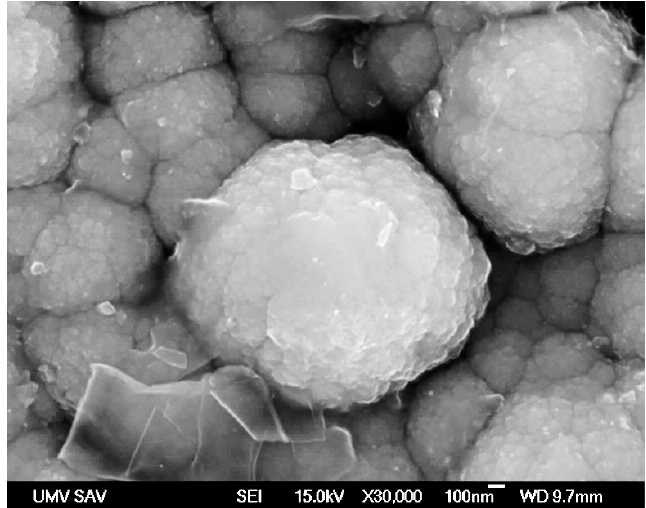
Figure 1. SEM image of the WC/C coating deposited on the steel substrate.